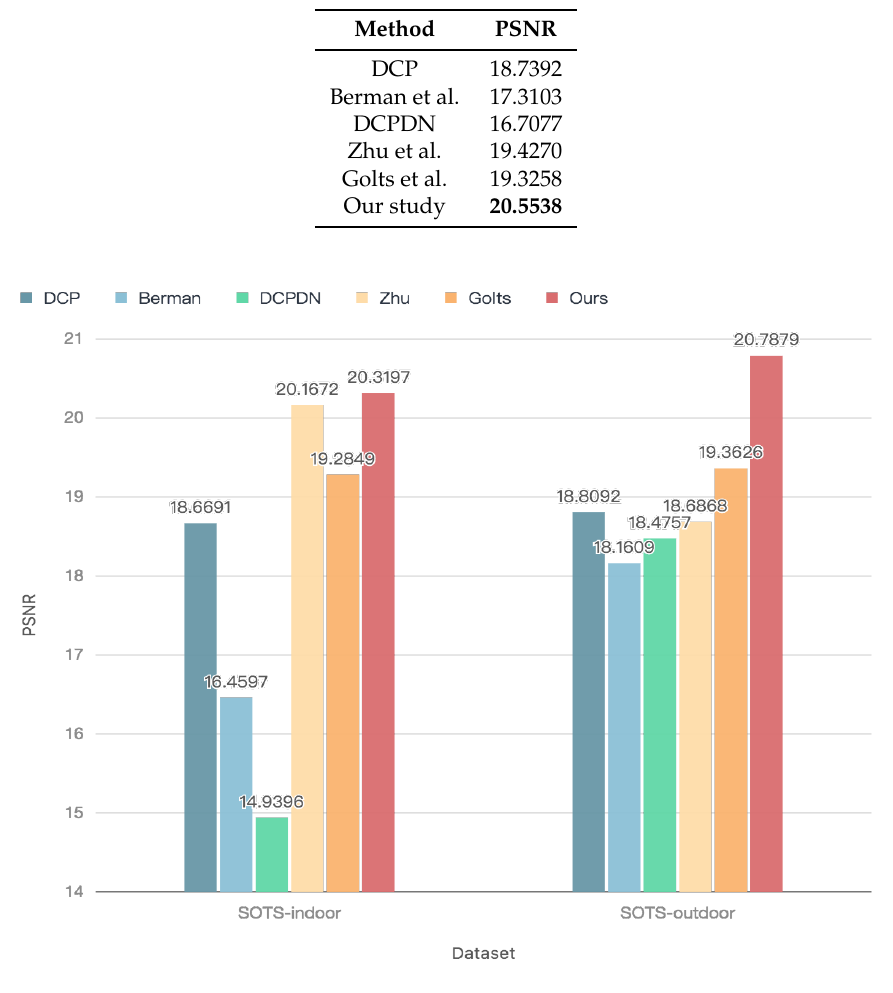
Table 4. The average PSNR of dehazed images in the RESIDE test dataset.